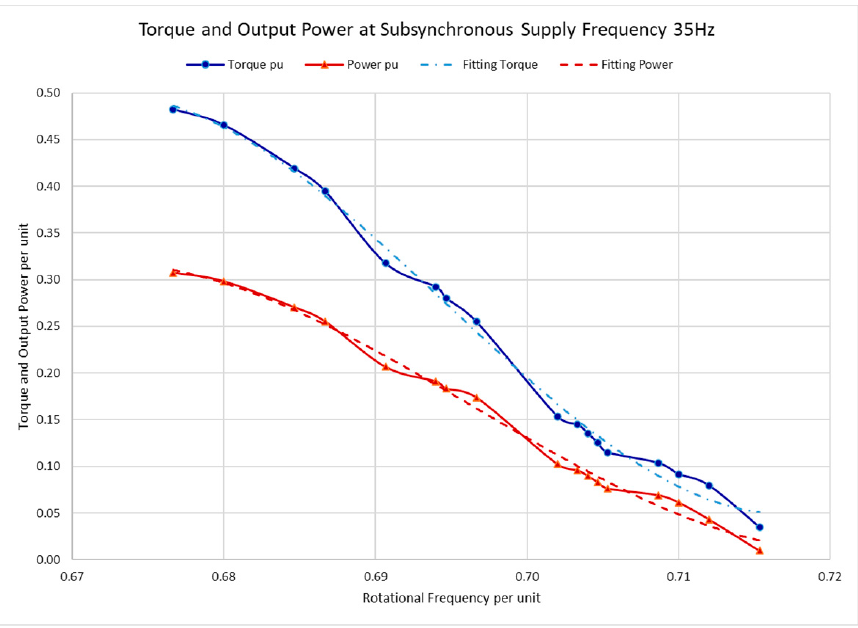
Figure 11. Torque and mechanical power vs. rotational frequency at input frequency 35 Hz (0.7 per unit).